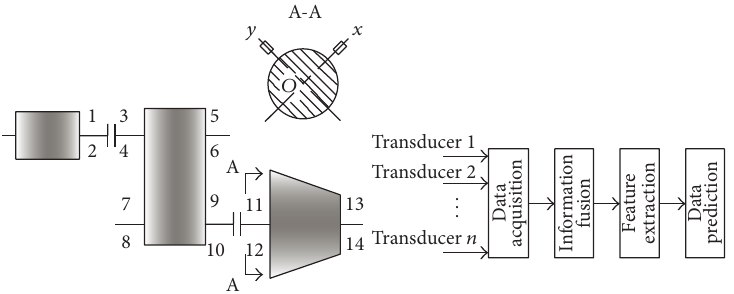
Figure 1: Diagram of prediction system based on full vector